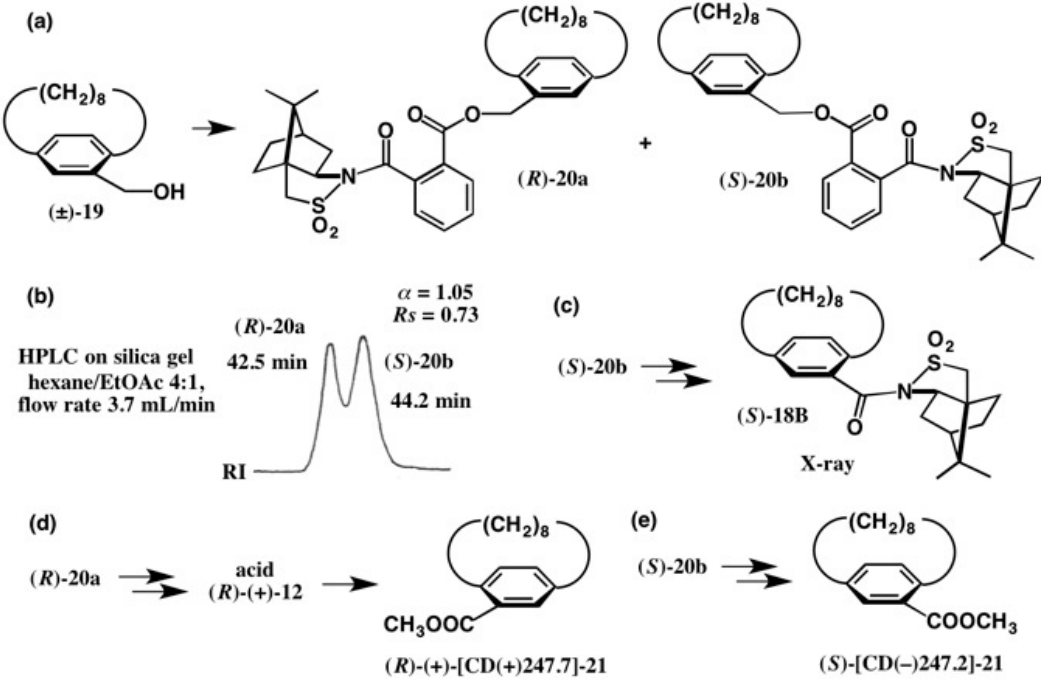
Figure 15. Preparation ( a ) and HPLC separation ( b ) of esters 20a and 20b , which were then converted to methyl esters ( R )-(+)- 21 ( d ) and ( S )- 21 ( e ), respectively. Ester 20b was converted to amide 18B ( c ), by which the ACs of these compounds were established. HPLC, redrawn from [24].